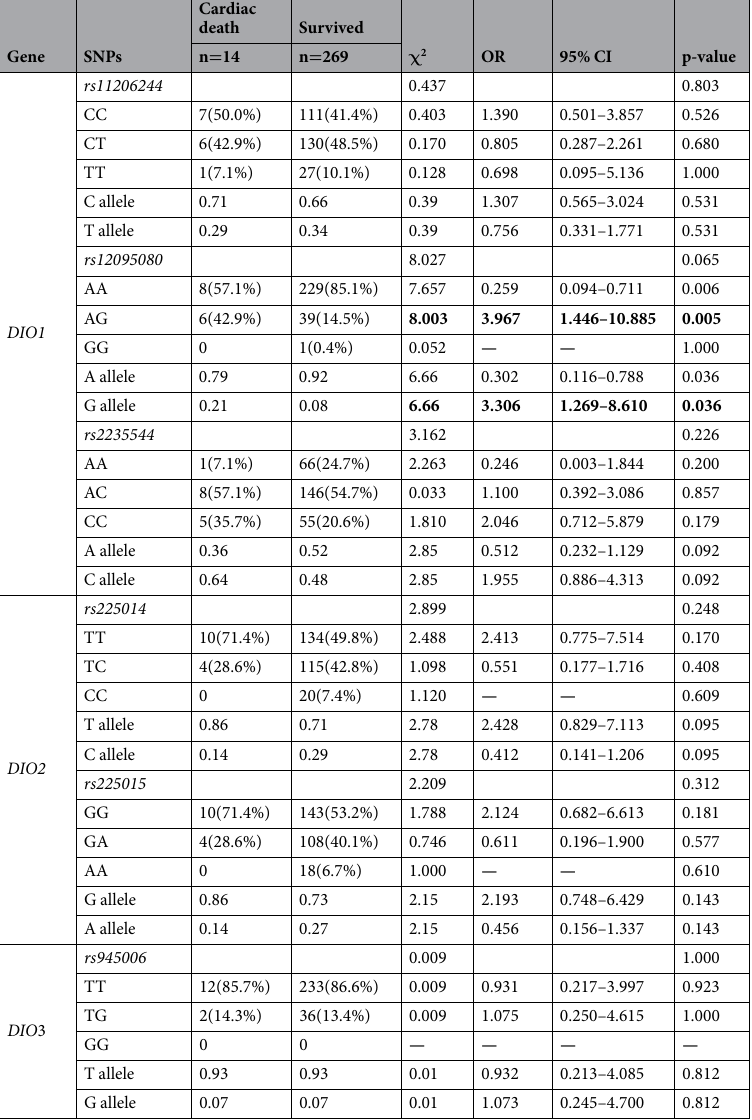
Table 4. Association between deiodinases genotype and two year cardiac-related mortality. DIO – deiodinases, SNP – single nucleotide polymorphism. Values are presented as number (percentage). p-values are presented for Hardy-Weinberg equilibrium (HWE) test and the Chi-square test or Fisher’s exact test as appropriate. Bold values: p-value < 0.05 was regarded as significant. Source : HWE: www.had2know.com/academics/hardy-